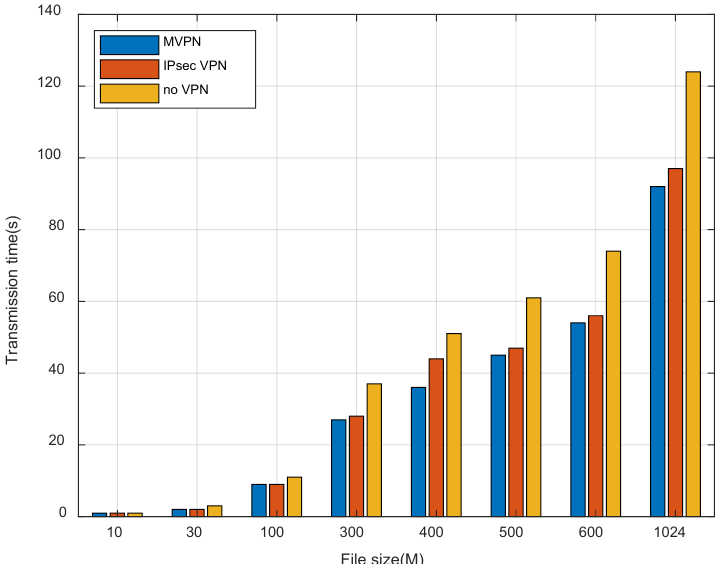
Figure 15. Relation between file transfer time and size.